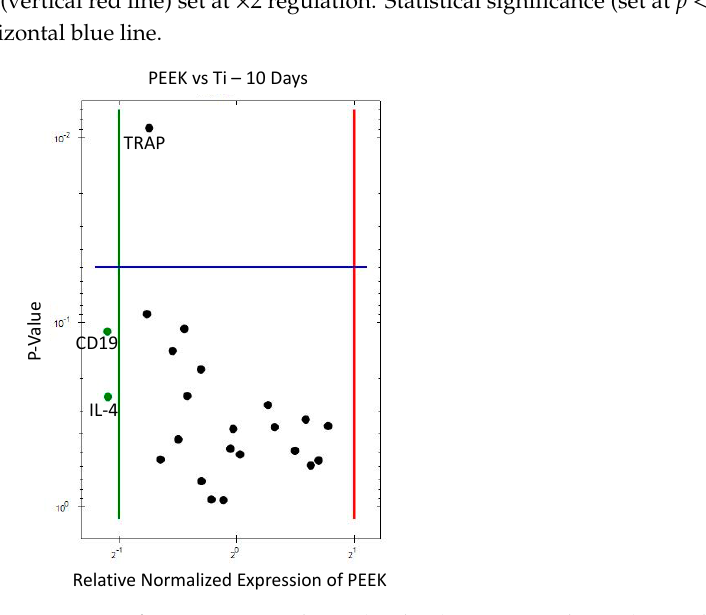
Figure 3. Volcano plot for gene expression of PEEK compared to Ti (10 days). Downregulation (vertical green line) and upregulation (vertical red line) set at ×2 regulation. Statistical significance (set at p < 0.05) when marker above horizontal blue line. Table 3. Gene expression analysis of Cu compared to Ti (10 days).